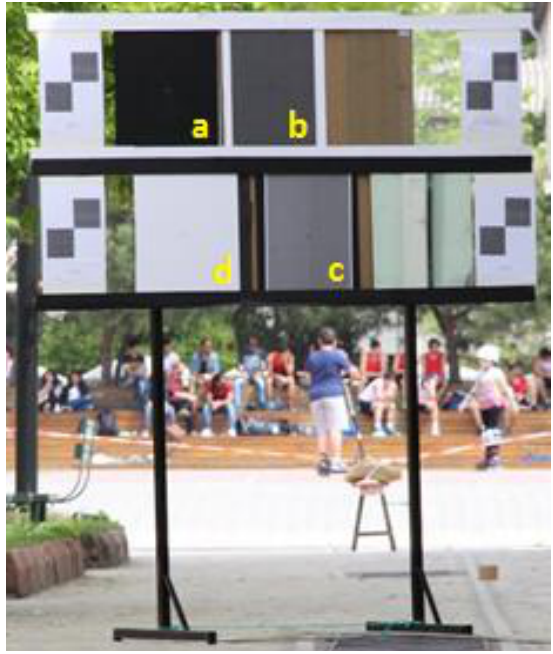
Using distance values acquired by Equation 10, Least Square Plane RMSE was computed for each coated glass. The variation of Least Square Plane RMSE is shown in Figure